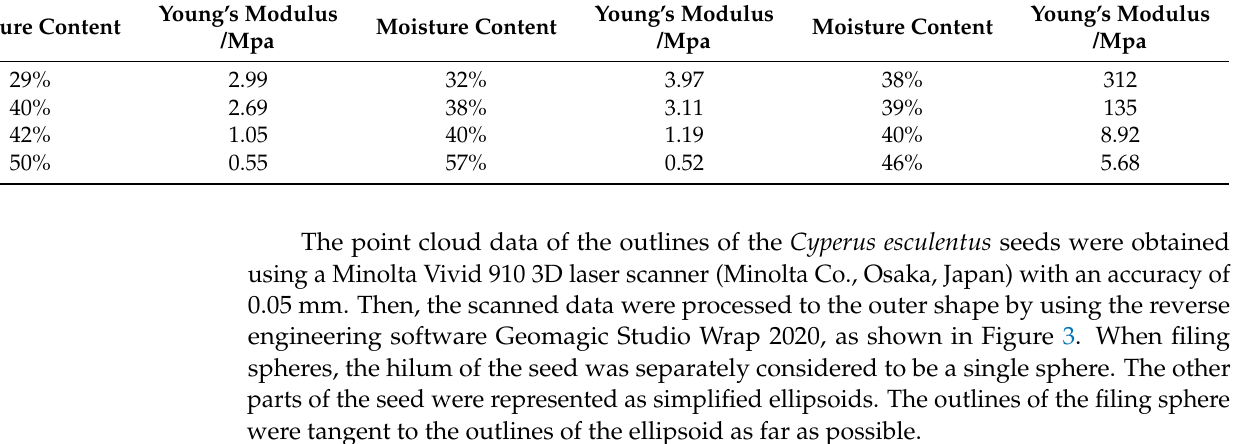
Table 3. The Young’s modulus of different moisture content for Cyperus esculentus seed.